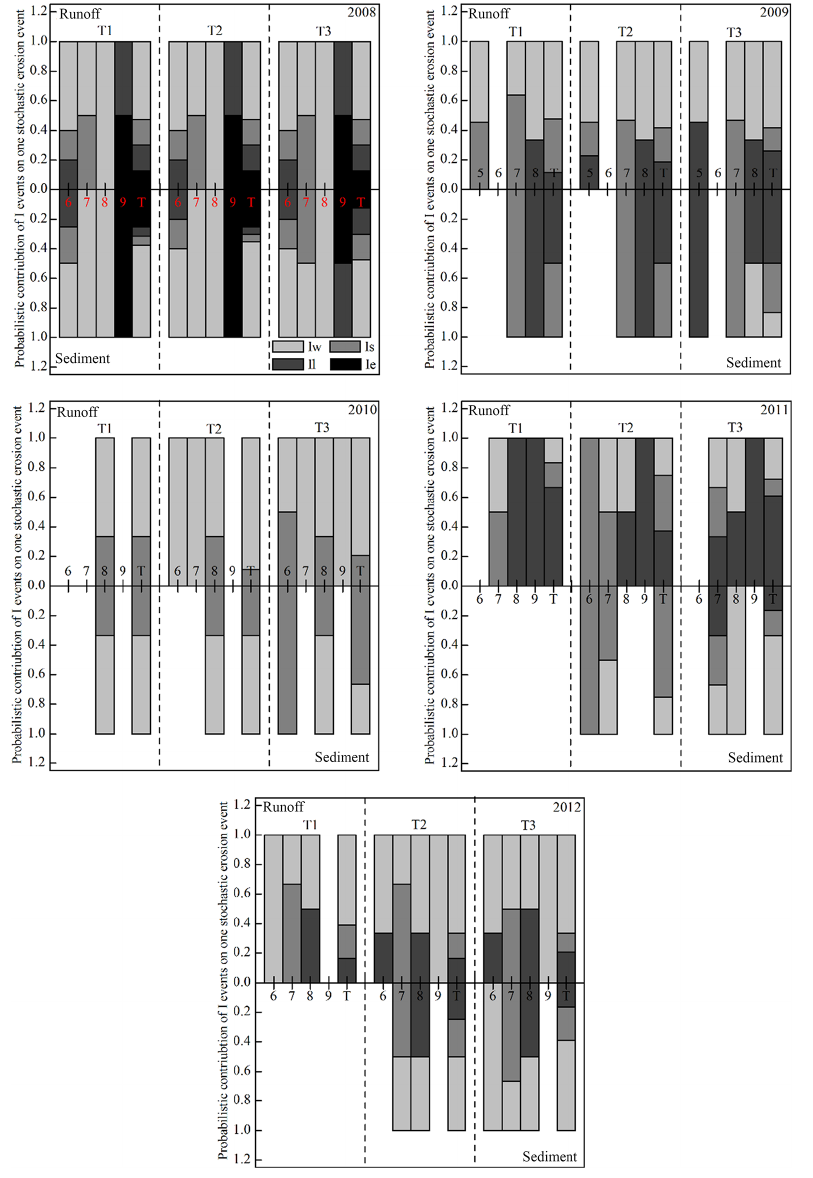
Figure 6. The distribution of probabilistic contribution of four random rainfall event types on any one runoff or sediment event stochastically occurring in three restoration vegetation types at monthly and seasonal scales from rainy season of 2008 to